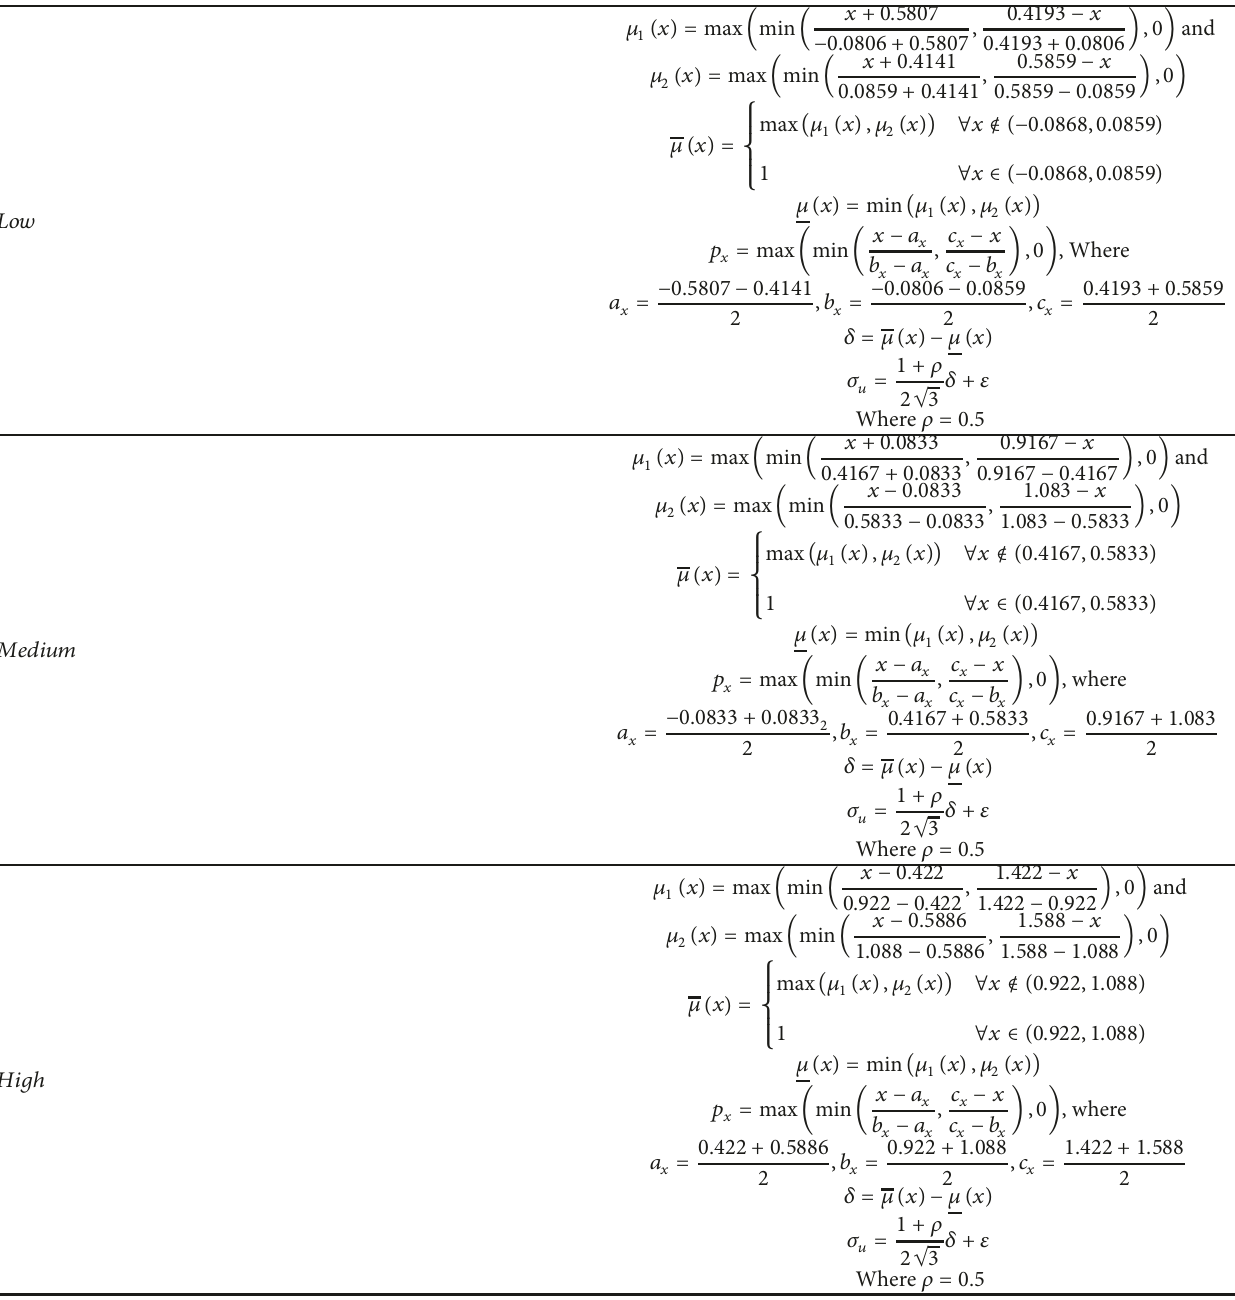
Table 3: Generalized type-2 membership functions for the input and output variables.